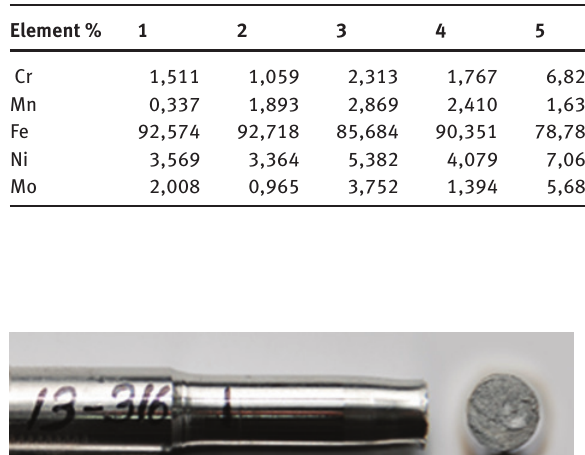
Table 5: EDS data of Ck 45 steel for sample 13